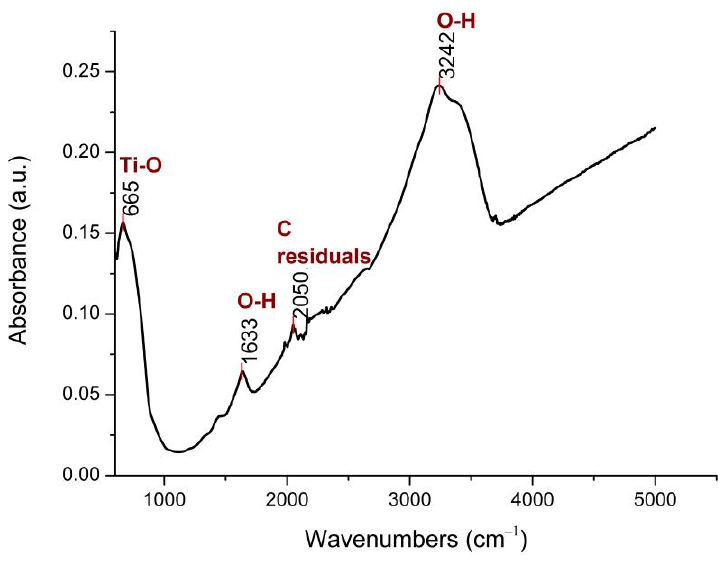
Figure 1. FTIR spectrum of N-TiO 2 powder, at 25 °C.